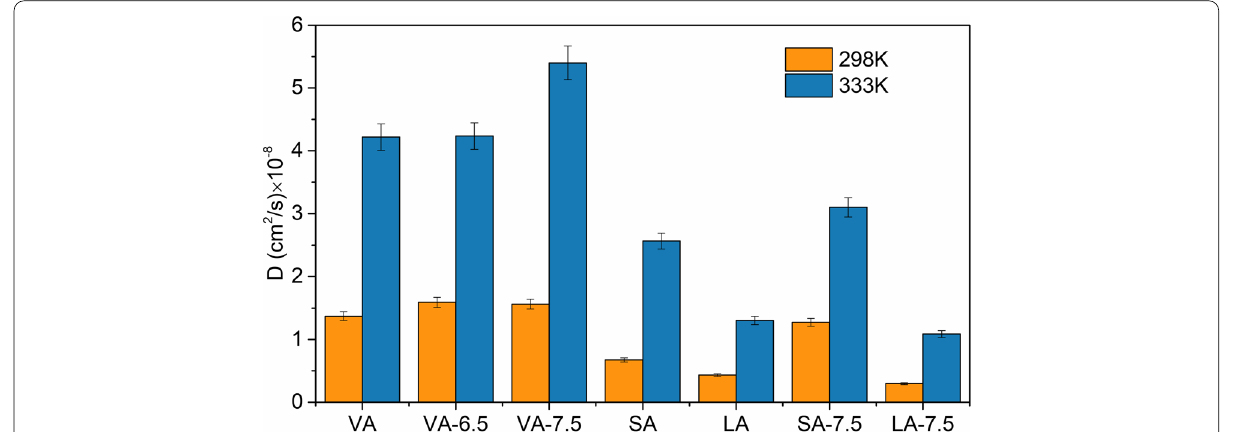
Fig. 17 Diffusion Coefficient of the Asphalt Models during Self-Healing Process at the Temperatures of 298 K and 333